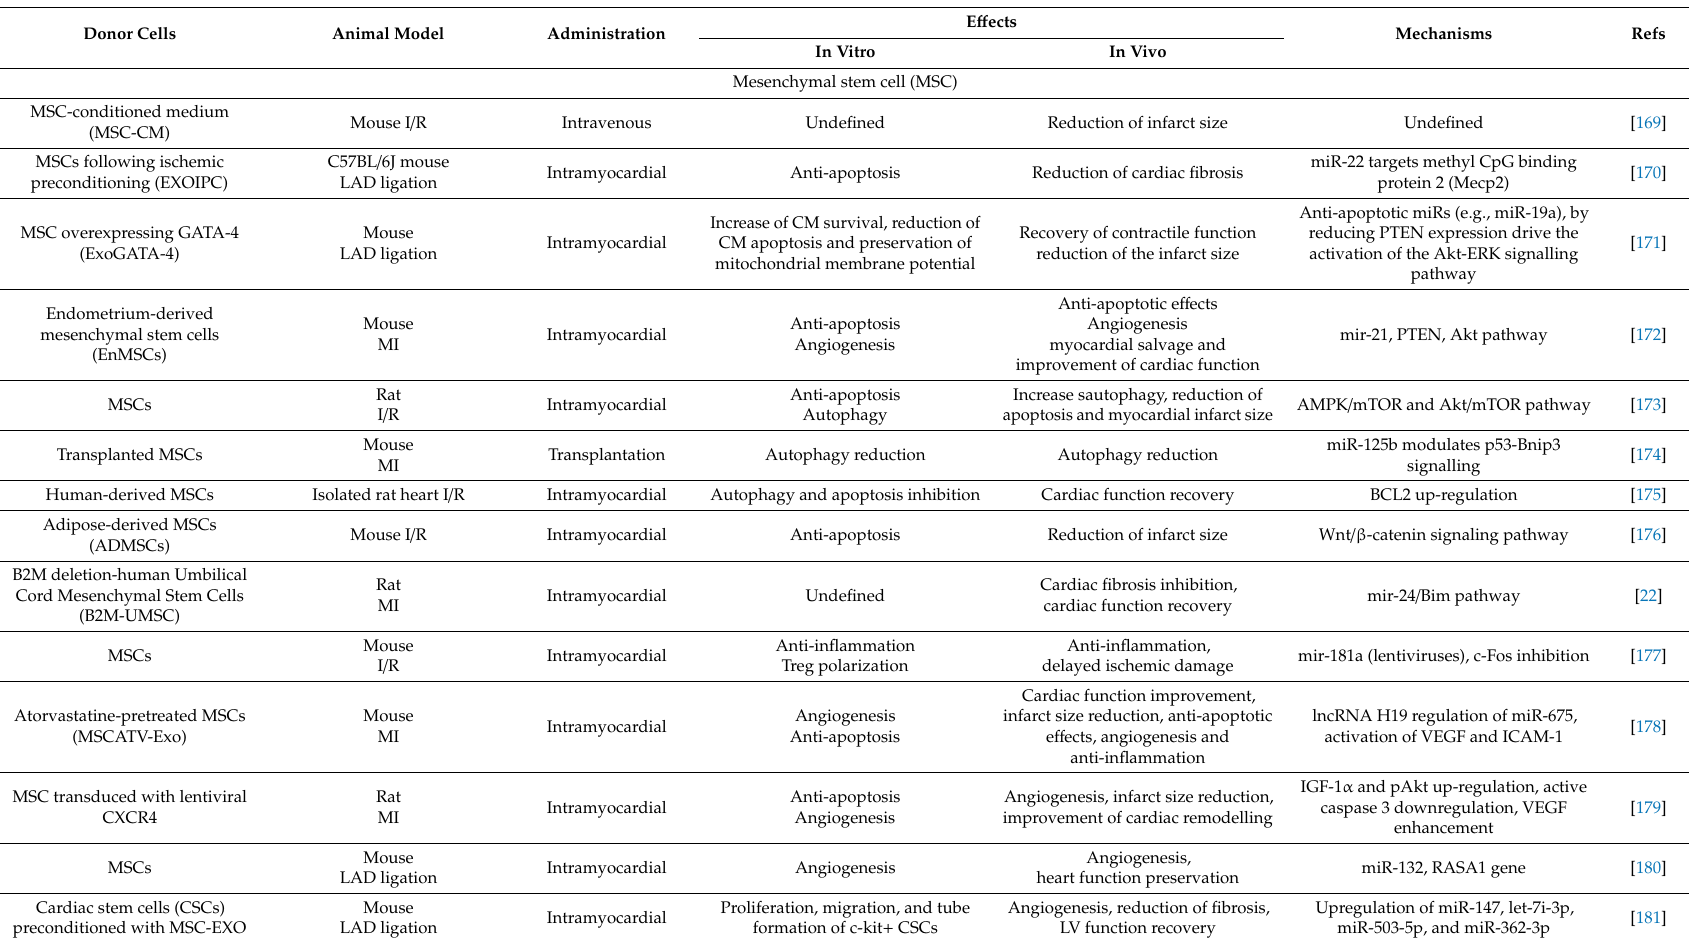
Table 3. Exo in cardioprotection /